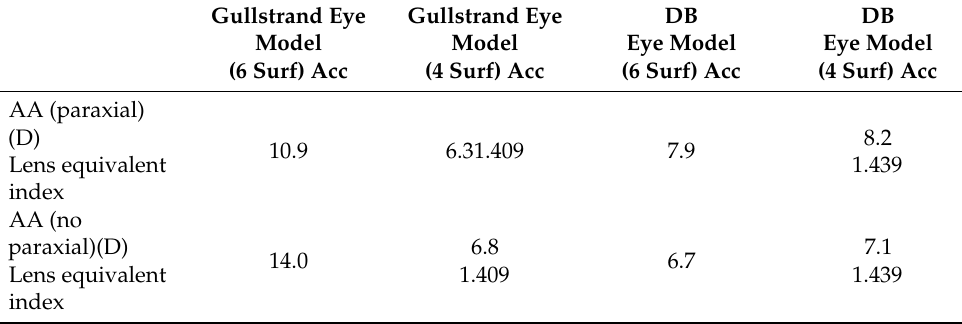
Table 2. Paraxial and non-paraxial (5 mm pupil) accommodation of the two eye models in Table 1, for a vergence change of 10 D. The equivalent refractive index corresponded to the refractive index for a homogeneous lens that had the same accommodation as the two-component lens with outer surface changes in the two surfaces lens of the relaxed